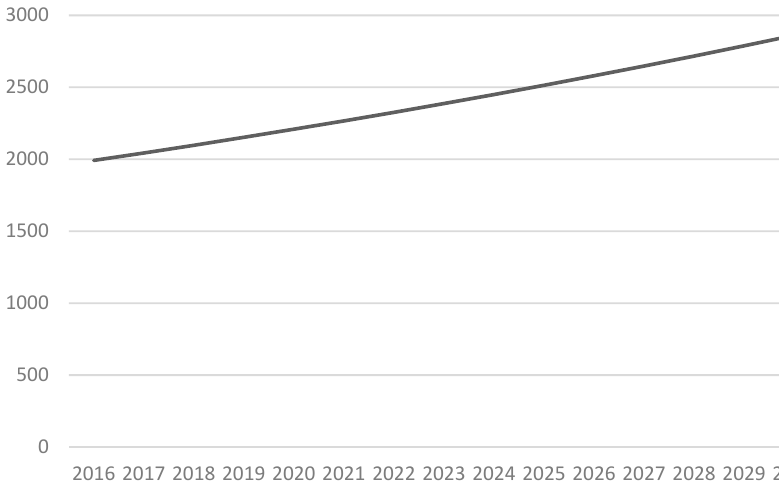
Figure 7. Household growth (Thousands of households per year).